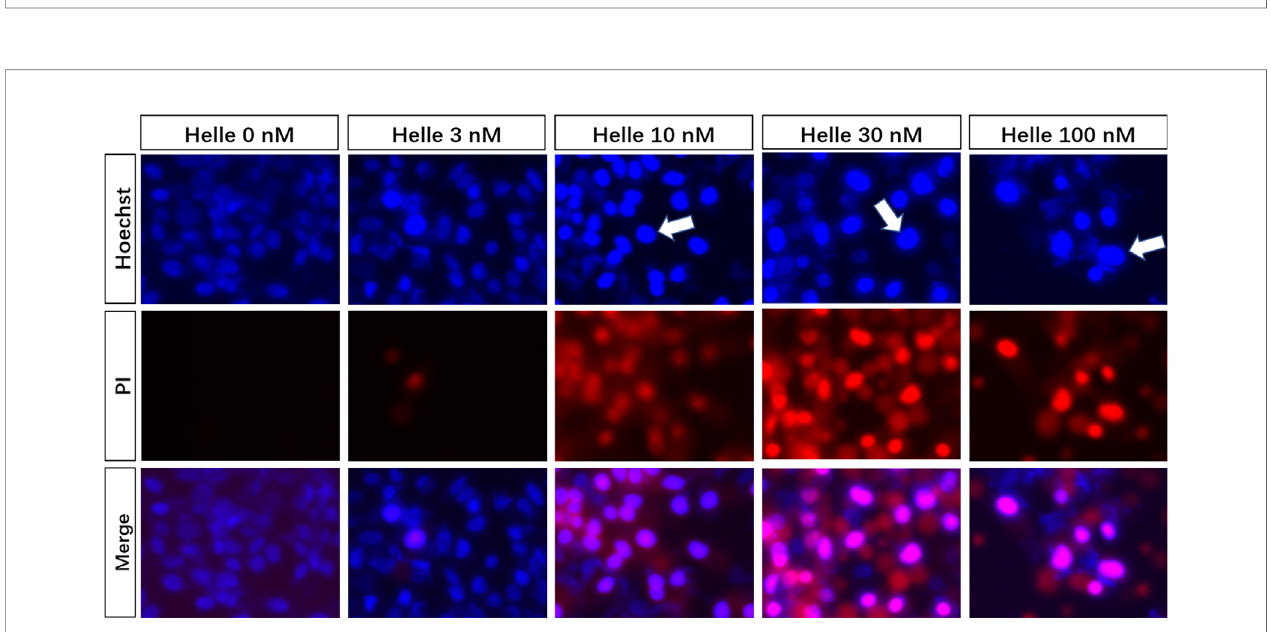
FIGURE 2 | Inhibition of colony formation of MCF-7 and MDA-MB-231 cells by Helle and Areno. The cells were seeded at 2,000 cells/well in 12-well plates following treatment with indicated concentrations (1, 3, 10, 30, 100, 300 and 1000 nM) of Helle and Areno for 24 h. Representative images of the clonogenic assays are shown from three independent experiments (A) . The relative colony formation rate was expressed as the ratio of the absorbance at 550 nm of each treatment group against those of the corresponding untreated control group as described in Materials and methods (B) . Data are shown as means ± SD from three independent experiments. *p < 0.05; ┼ p < 0.01; ╪ p<0.0001 vs. control. Helle, hellebrigenin; Areno, arenobufagin.